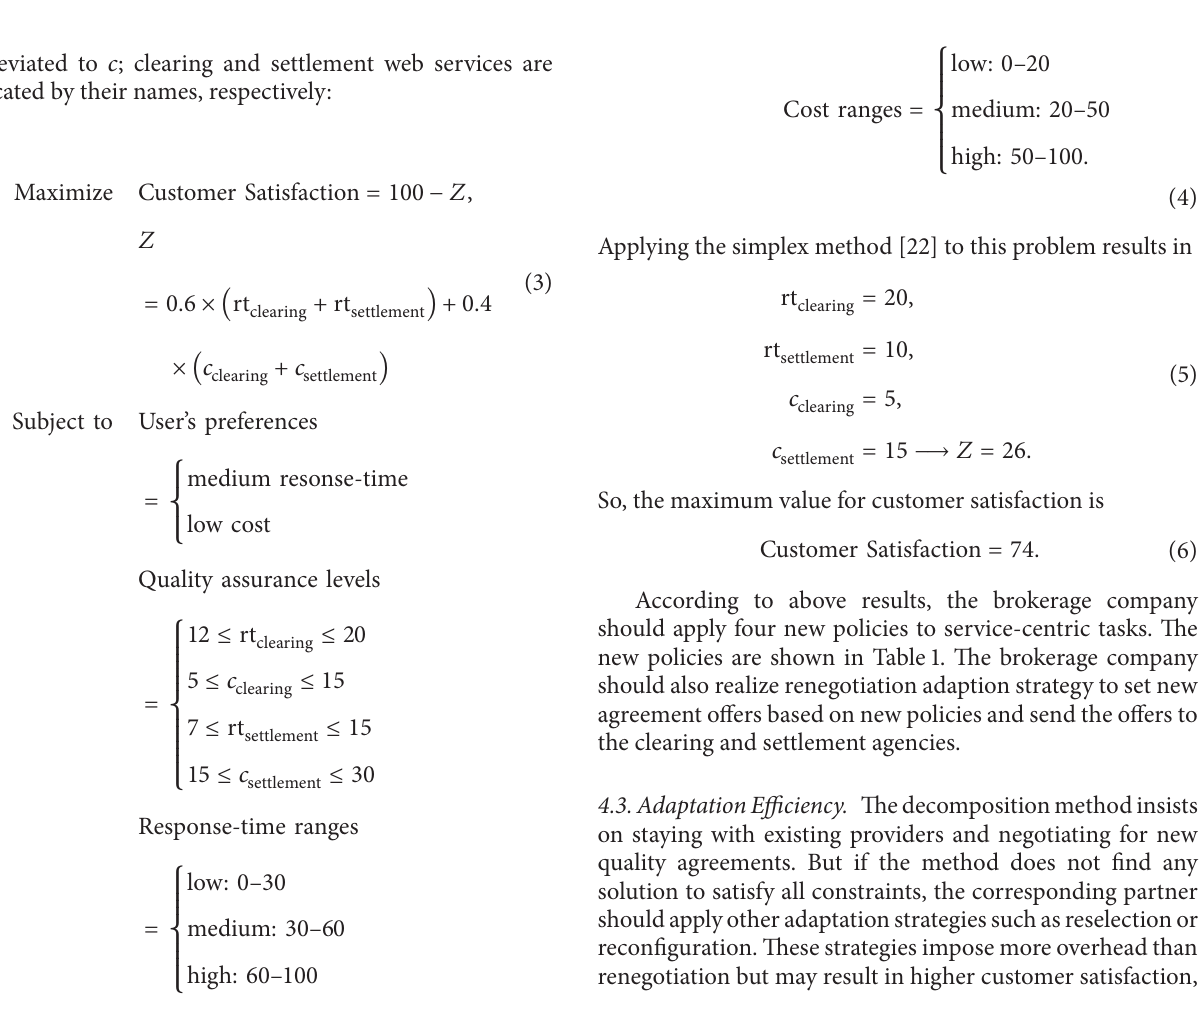
Figure 5: Securities settlement